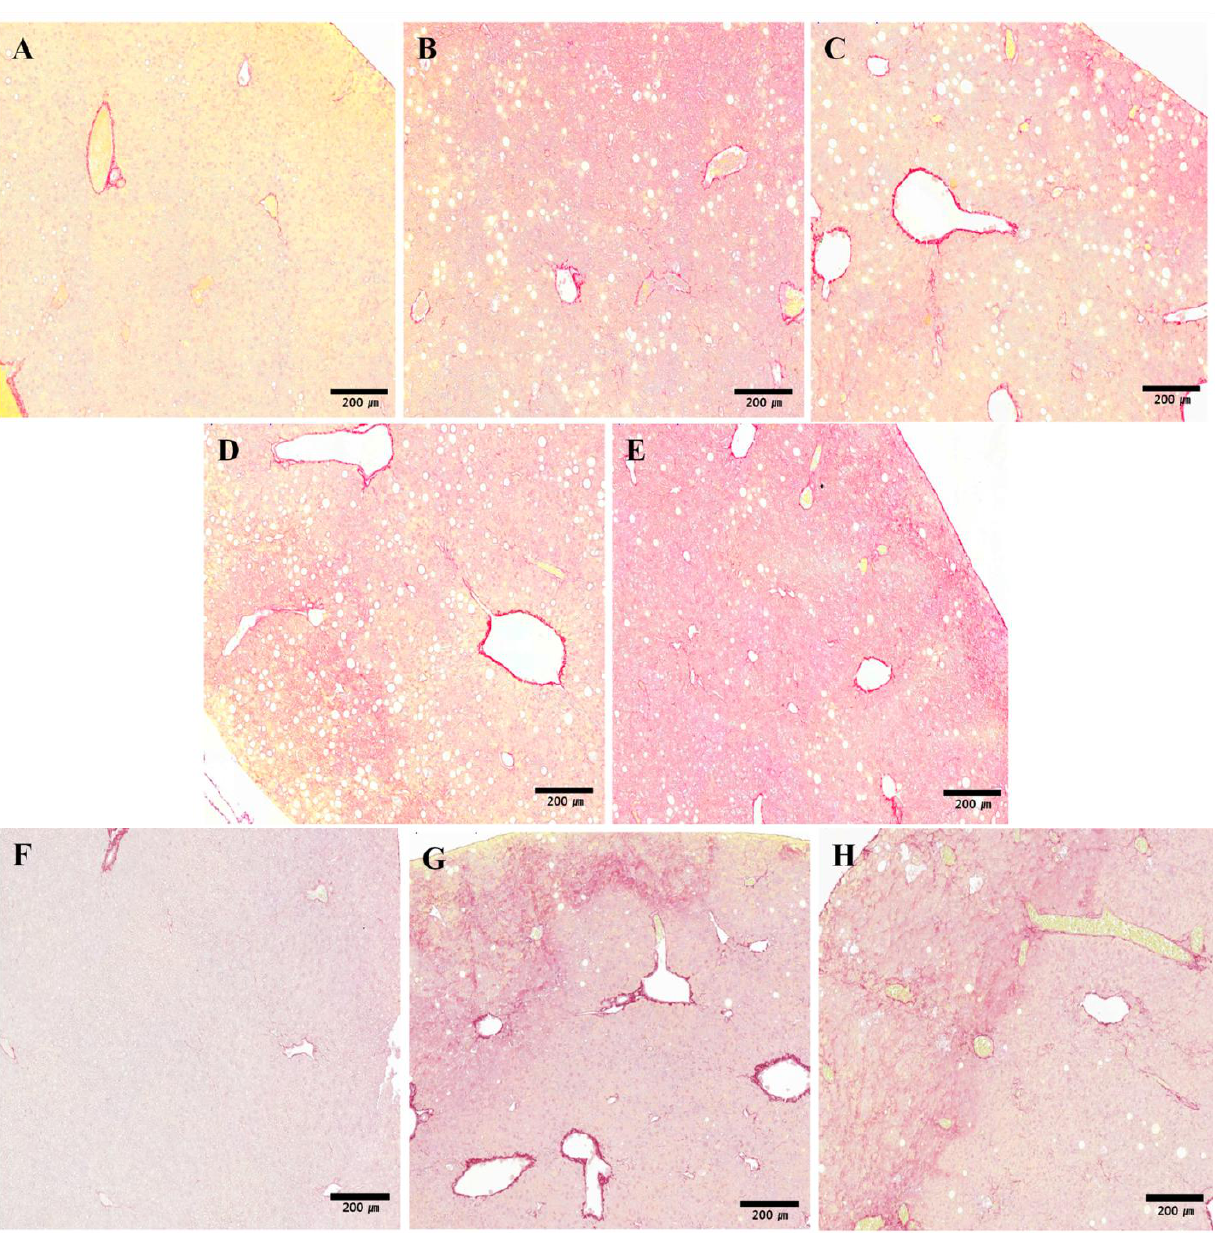
Figure 3. Effects of SME on histopathological changes induced by MCD diet in liver sections stained with Sirius Red. ( A ) Normal group (normal diet only); ( B ) Control group (MCD diet only); ( C ) Low-dose group (SME; 0.1 mg/kg/day); ( D ) Mid-dose group (SME; 0.5 mg/kg/day); ( E ) High-dose group (SME; 1 mg/kg/day) for 4 weeks (magnification ×200) and ( F ) Normal group (normal diet only); ( G ) Control group (MCD diet only); ( H ) Low-dose group (SME; 0.1 mg/kg/day); ( I ) Mid-dose group (SME; 0.5 mg/kg/day); ( J ) High-dose group (SME; 1 mg/kg/day) for 6 weeks (magnification ×200); ( K , L ) Quantification of collagen accumulation is expressed as mean ± SD, * p < 0.05 vs. MCD diet